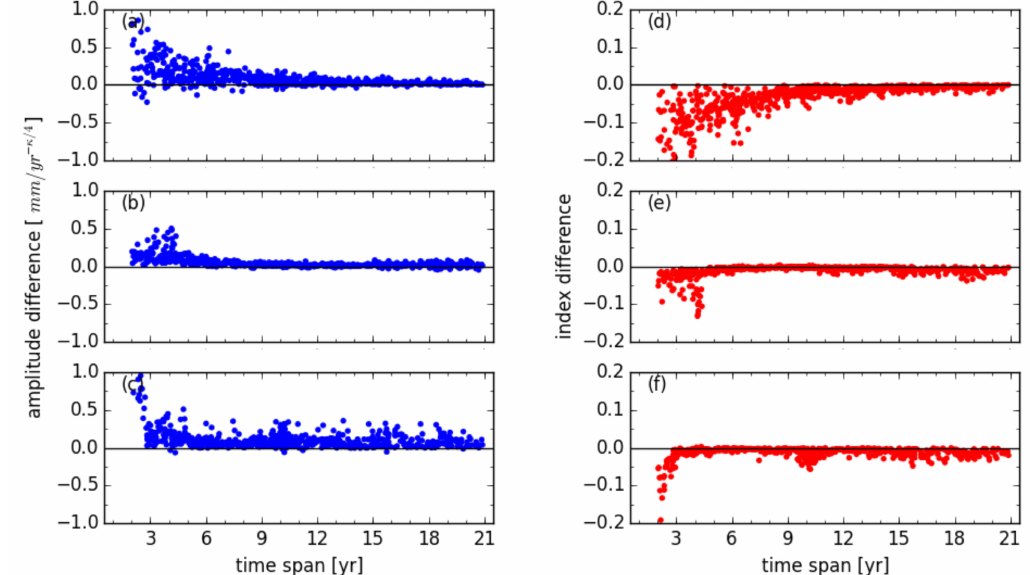
Figure 2. Noise difference between simulated noise and those derived from solution sim_unit_none for amplitudes ( left panel ) and spectral indexes ( right panel ) of power-law noise, with ( a , d ) for the east, ( b , e ) for the north, and ( c , f ) for the vertical